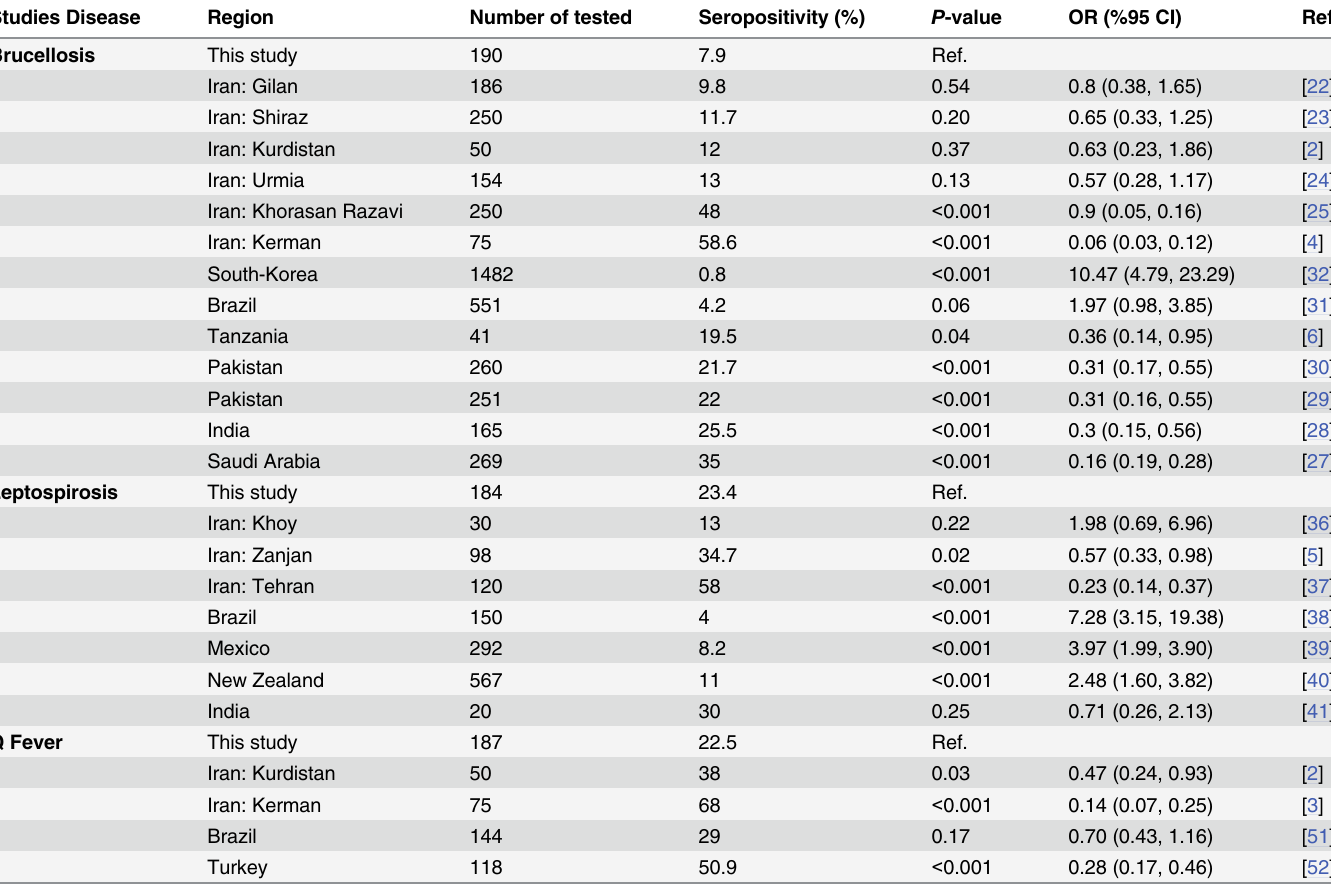
Table 3. The comparison of the seroprevalence surveys of brucellosis, leptospirosis and Q fever carried out in different areas among butchers and slaughter workers. Studies Disease Region Number of tested